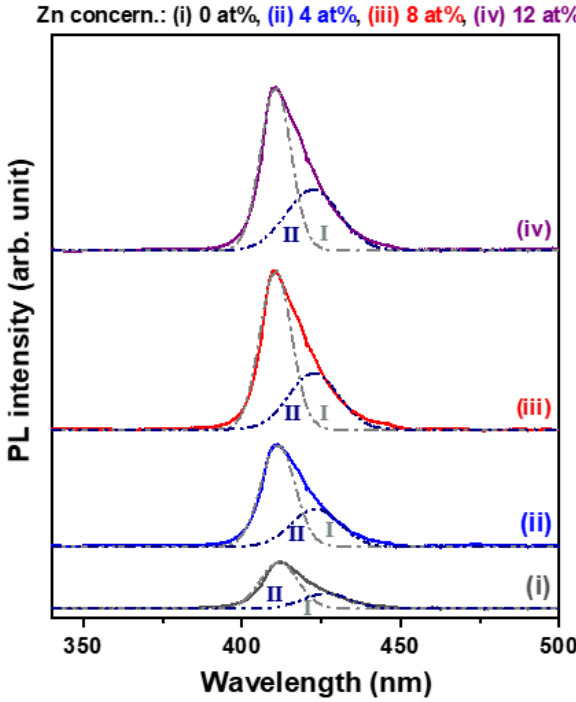
Figure 4. Room-temperature PL spectra of the Zn-substituted CuI thin films.